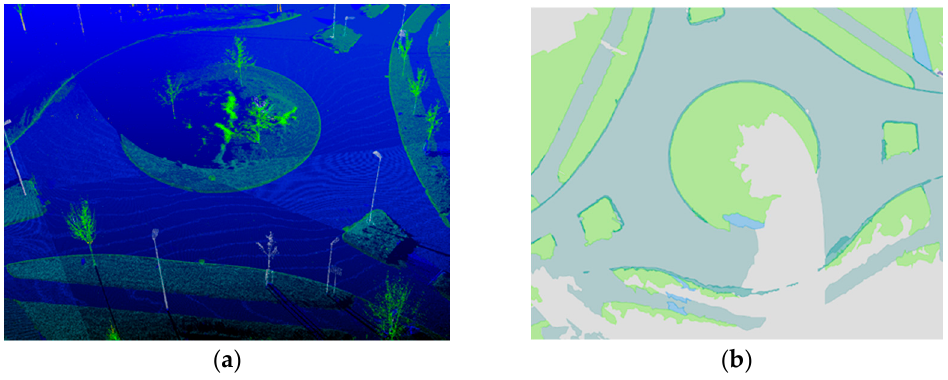
Figure 10. Incomplete polygon map (a) due to shading by a hill in the point cloud (b). It is possible to close this data gap with additional sensors or a more redundant recording strategy.